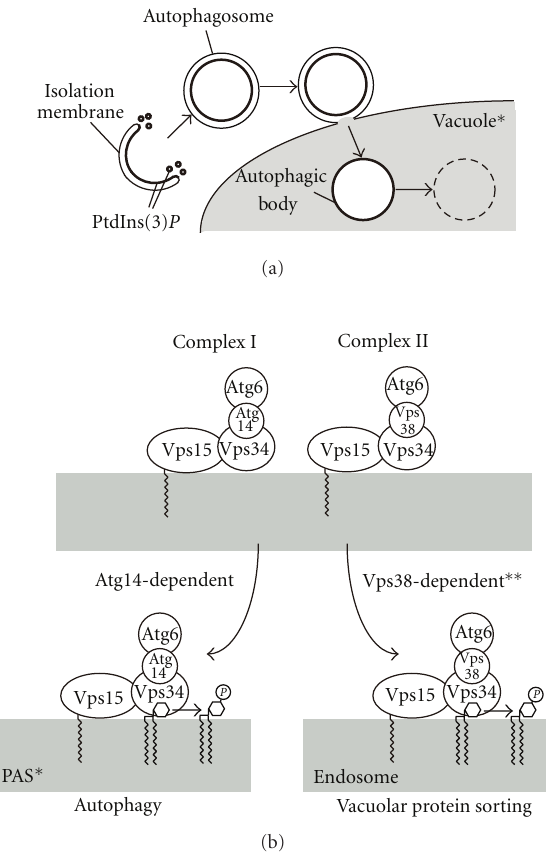
Figure 1: Atg14 is a key factor in determining the function of the PtdIns 3-kinase complex. (a) Membrane dynamics of autophagy and movement of PtdIns(3) P in yeast. The isolation membrane extends to enclose the cytoplasmic contents. The closed double- membrane structure, the autophagosome, fuses with the vacuole and releases the inner membrane structure, the autophagic body, into the lumen where the enclosed contents are degraded [25]. PtdIns(3) P (bold line) is enriched at the inner surface of the isolation membrane and the autophagosome [26]. PtdIns(3) P is also enriched on some uncharacterized amorphous membranes near the tips of the isolation membrane. ( ∗ ) In mammals the au- tophagosome fuses with the lysosome, which is often smaller than the autophagosome, and the released lysosomal hydrolytic enzymes degrade the inner membrane structure to become the autolysosome. (b) Assortment of PtdIns 3-kinase complexes in yeast. Yeast has at least two PtdIns 3-kinase complexes (Complexes I and II). Atg14 is a specific subunit of Complex I. Atg14 targets Complex I to the PAS, thereby, providing Complex I with the ability to function in autophagy. In mammals, in addition to Complexes I and II, a third complex exists in which Rubicon is added to Complex II; this complex negatively regulates maturation of the autophagosome. ( ∗ ) Instead of the PAS, Barkor/Atg14(L) targets the autophagy-specific PtdIns 3-kinase complex to an ER subdomain in mammalian cells. ( ∗∗ ) Although endosomal localization of the complete Complex II (including Atg6) is dependent on Vps38, that of Vps34 and Vps15 does not require Vps38. (a) and (b) reproduced from Obara and Ohsumi [26] (Copyright 2008 by Landes Bioscience) and [17] (Copyright 2011 by the Hindawi Publishing Corporation),